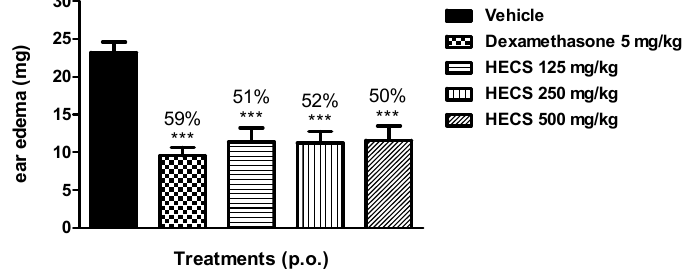
Figure 3. Effect of the hydroalcoholic extract of C. sicyoides— HECS (125, 250 and 500 mg/kg, p.o.) in the ear edema model induced by AA. The results are expressed as the mean ± S.E.M., and statistical significance was determined by ANOVA followed by Dunnett’s test; *** p < 0.001 compared to the control group (vehicle). The numbers in percentage in the figure corresponds to the reduction of the mean difference in weight (mg) of the ears in the control group ( n = 8).